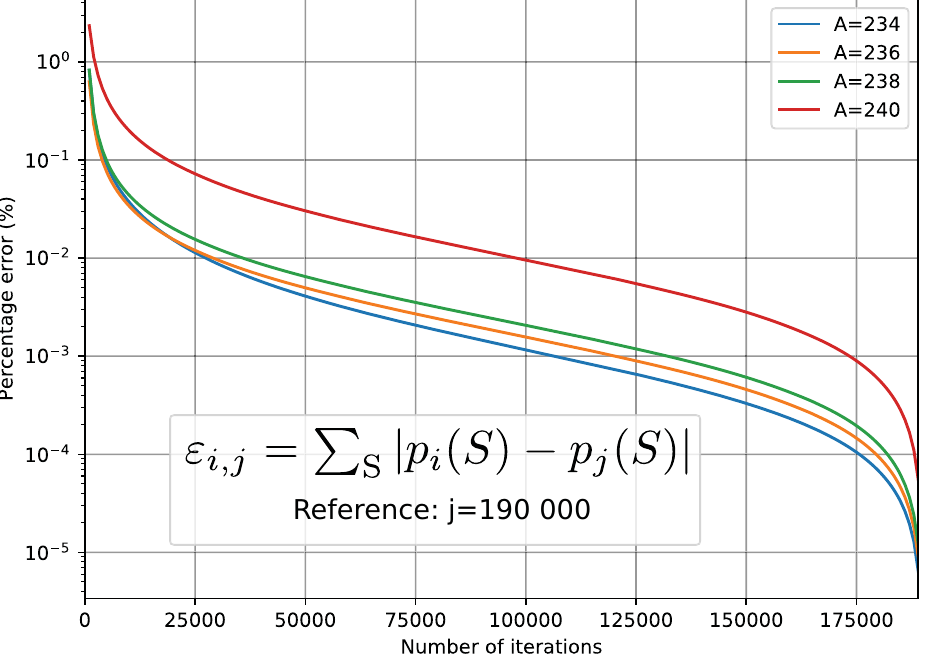
Figure 1. Relative error in the fragment distribution within DPS as a function of the number of time iterations (Z =